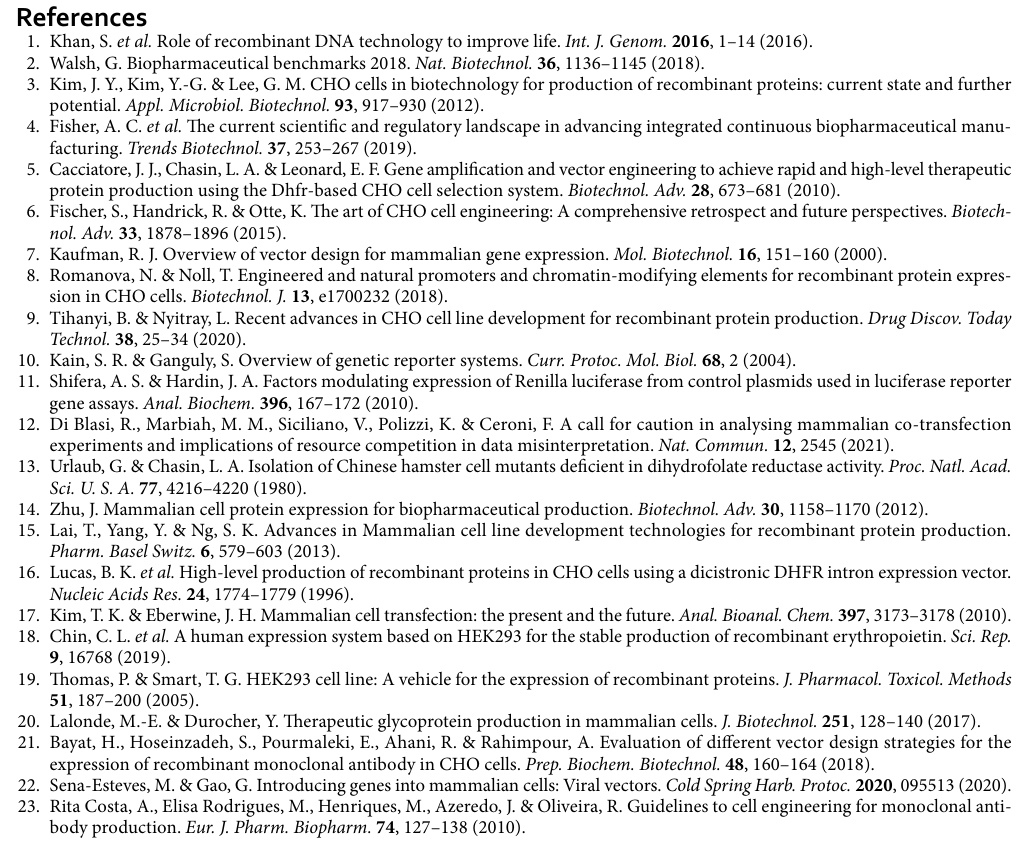
GAPDH gene 40 . The copy number of the DHFR gene for each CHO-DG44 stable clone was normalized relative to the GAPDH gene and the 176 number was used as the reference standard.